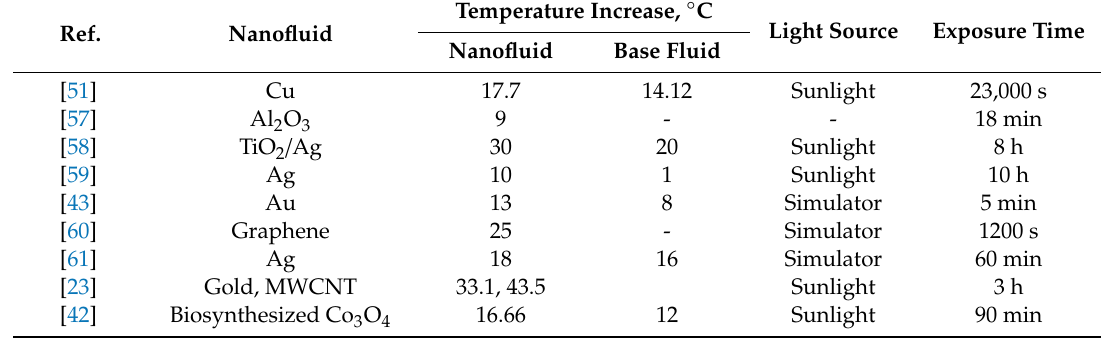
Table 2. Temperature rise achieved for various nanofluids [36]; 2019, Elsevier.